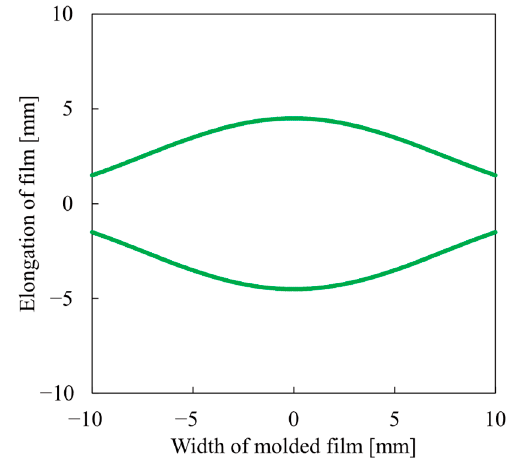
Figure 6. Development view of the molded shape. Table 1. Design parameter for pod structure.